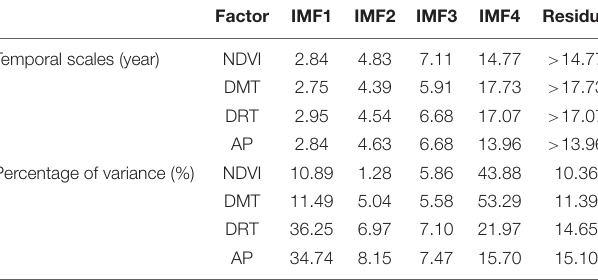
TABLE 1 | The averaged temporal scales and percentage of variance are explained by each intrinsic mode function (IMF) of NDVI, daily mean temperature (DMT), daily range of temperature (DRT), and accumulated precipitation